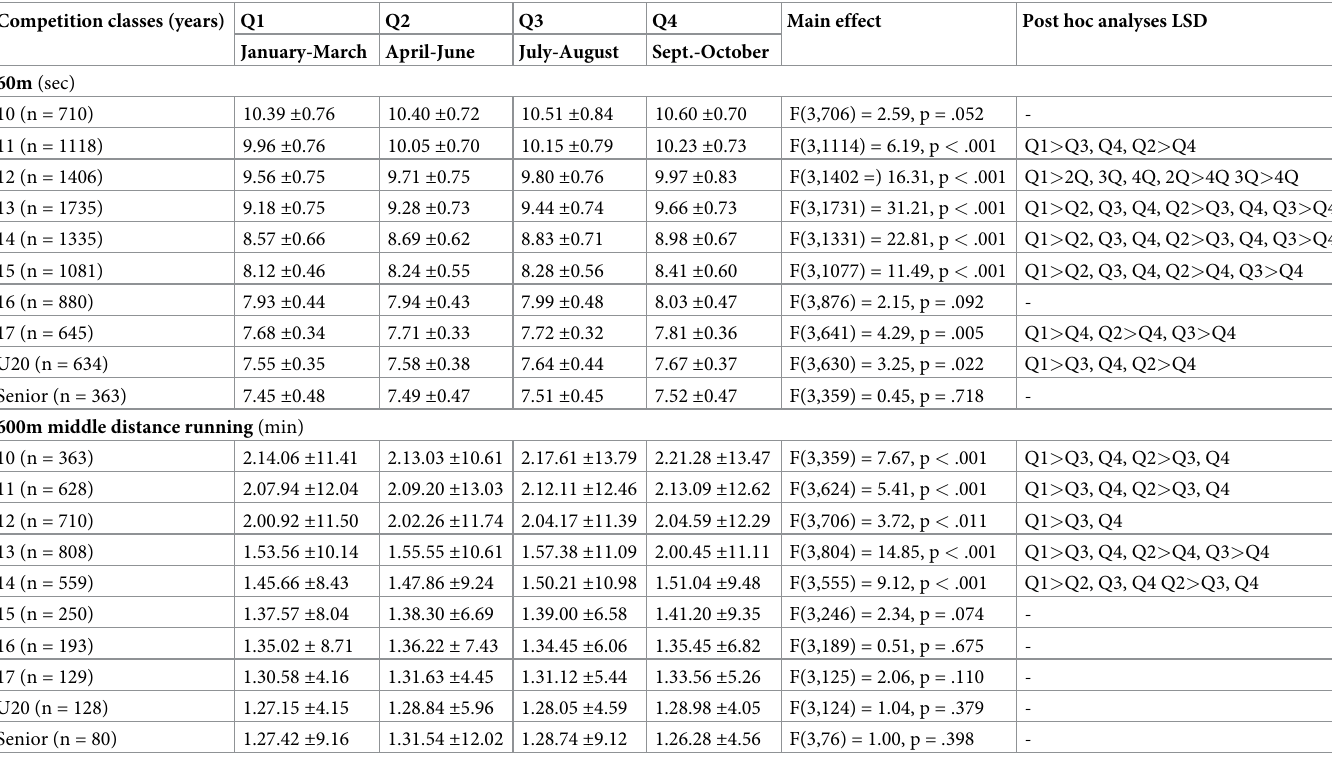
U20: 18–19 years, Senior: 20–34 years > indicate significant better performance for athletes born in quartiles at the left side of the sign compared to those born in quartiles at the right side.